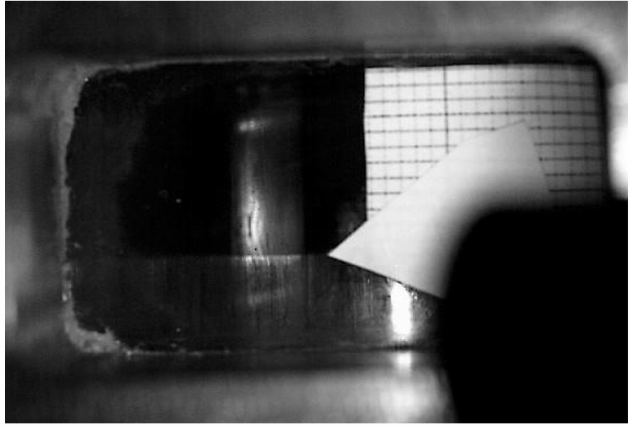
Figure 7. Reference used in the piston position measurements.